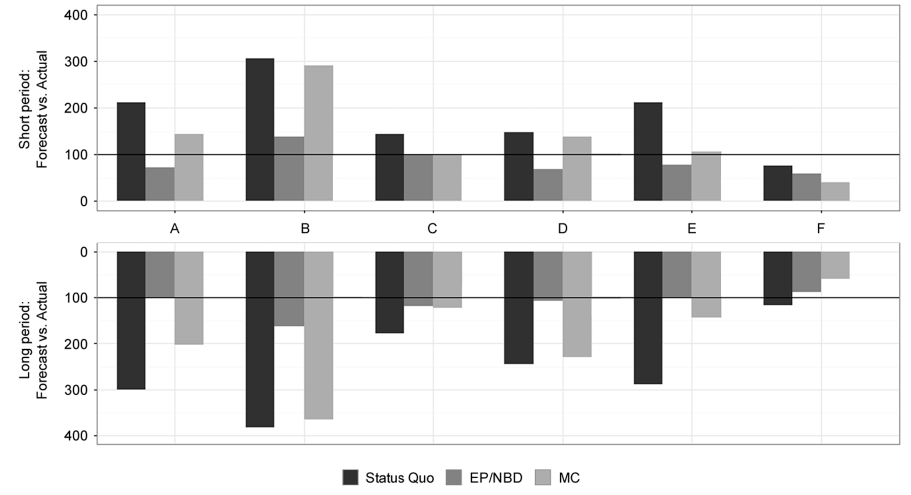
Figure A1. Results for Forecast vs. Actual (in %) for online stores A–F. Source: Authors.